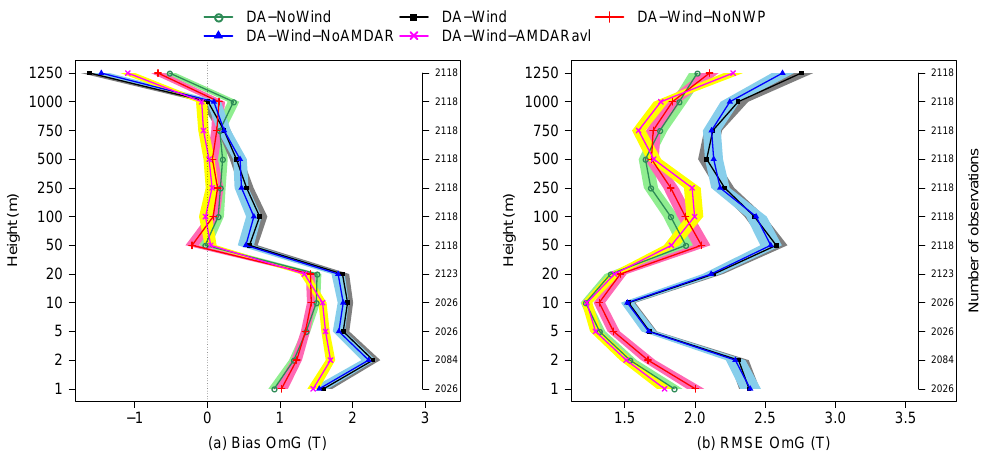
Figure 4. Background departure (OmG) statistics for temperature (T), averaged over the winter period (December 2015–February 2016): ( a ) Bias, and ( b ) RMSE. The number of observations used is shown on the right. The shaded areas represent the confidence intervals at